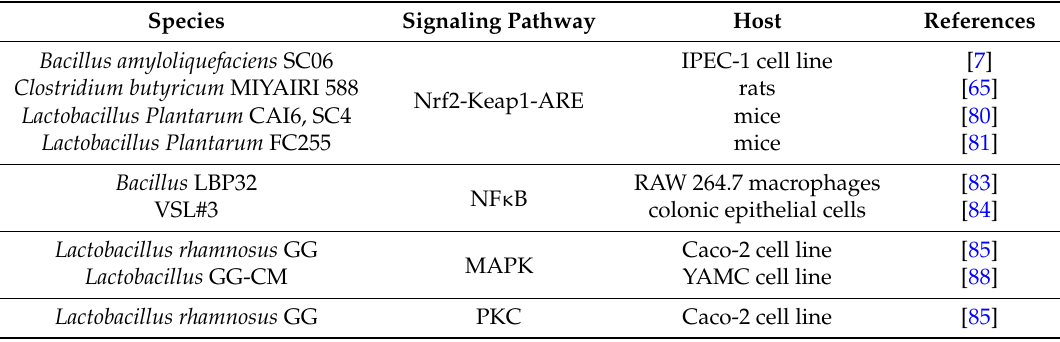
Table 1. Summary of antioxidant signaling pathways mediated by probiotic bacteria. Species Signaling Pathway